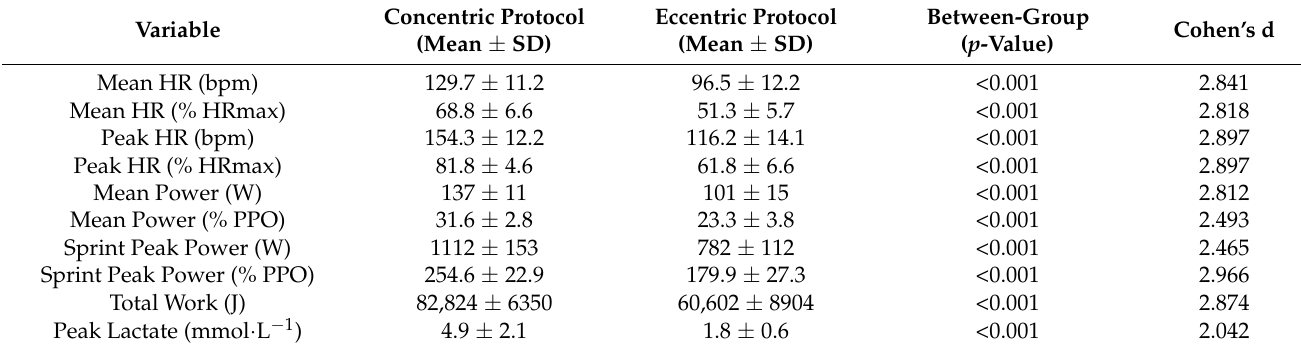
Table 1. Physiological and mechanical responses of the cycling